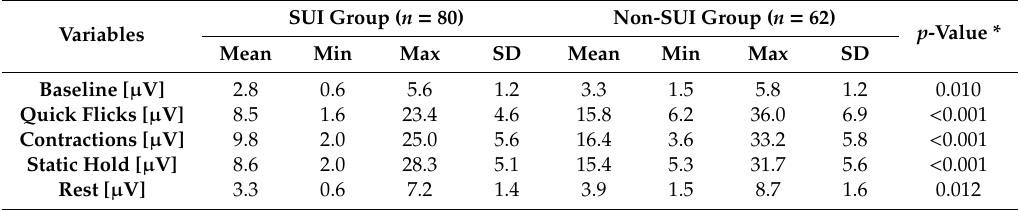
Table 2. Comparison of surface electromyography (sEMG) results between SUI and non-SUI women. Variables